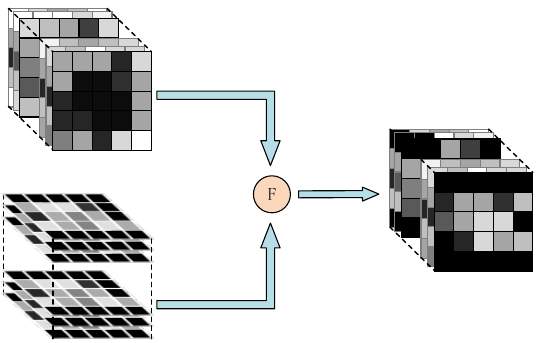
Figure 8. An illustration of the region-based fusion